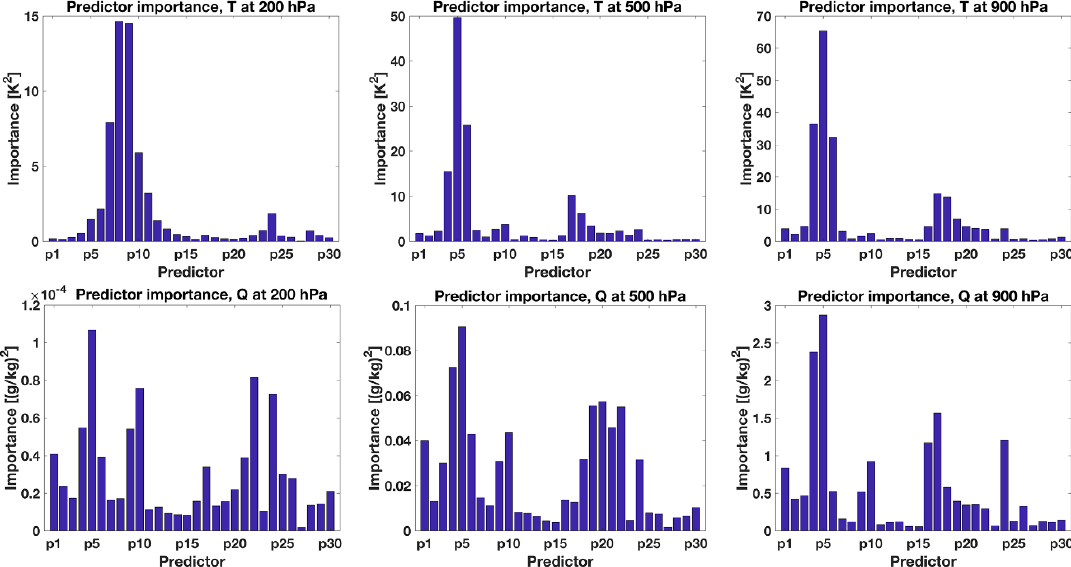
Figure 3. Predictor importance analysis for T ( top ) and Q ( bottom ) at three representative levels: 200 hPa (left), 500 hPa (center), and 900 hPa (right).